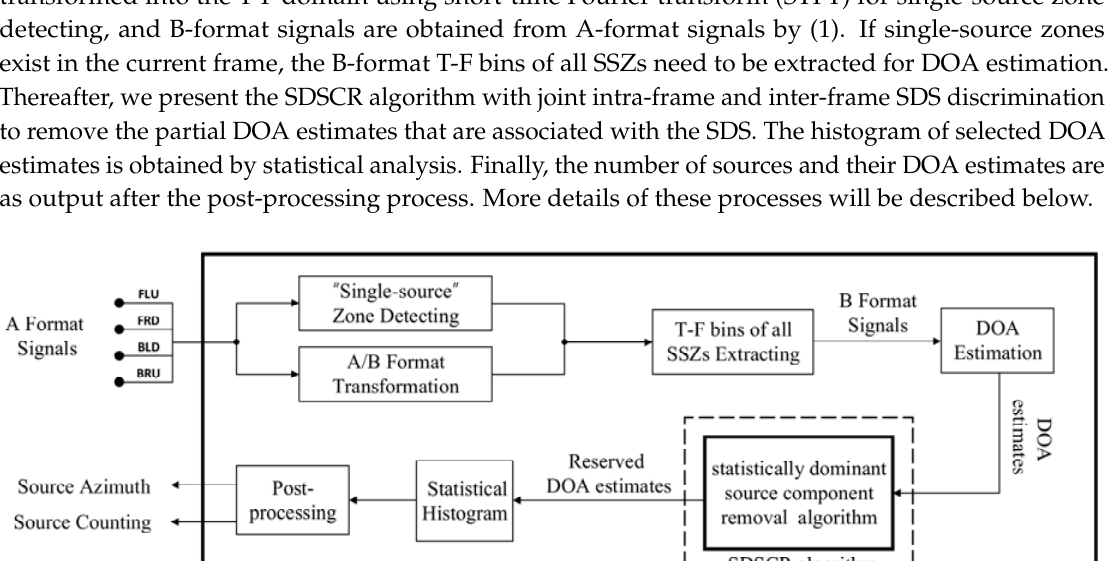
Figure 4. The block diagram for the proposed multiple sound sources localization framework.